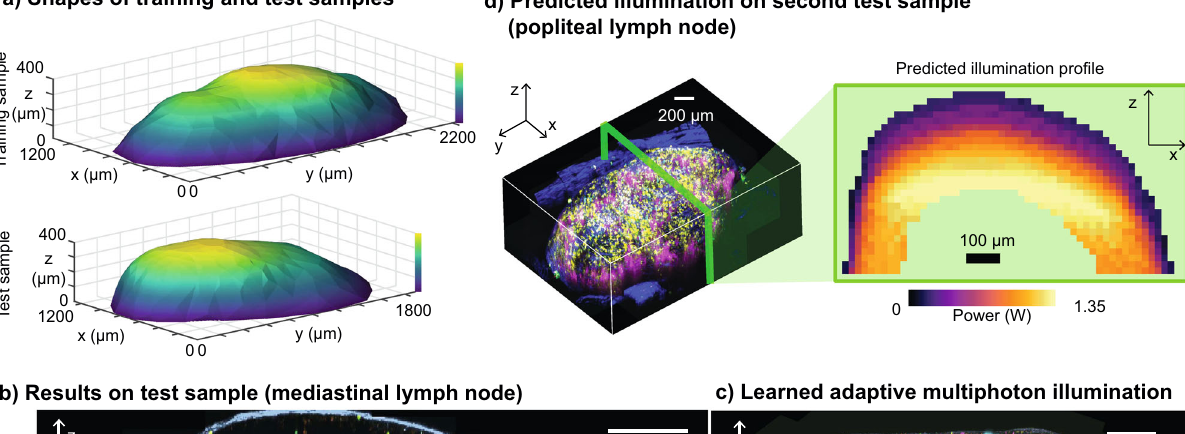
Mean intensity of Mean intensity of top 5% of pixels top 5% of pixels